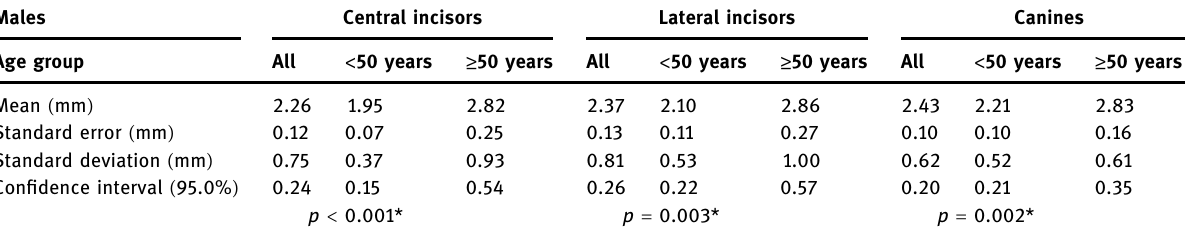
Table 3: Mean distance between the CEJ and BBC in males taking into account di ff erent groups of teeth Males Central incisors Lateral incisors Canines Age group All